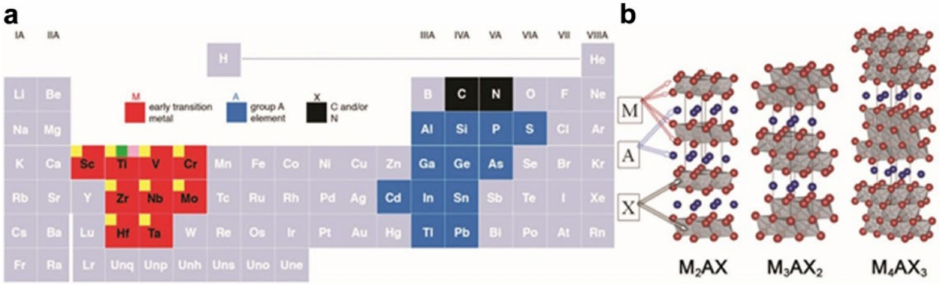
Figure 1. ( a ) The elements of the periodic table for MAX phases. ( b ) Structures of M 2 AX, M 3 AX 2 , and M 4 AX 3 phases